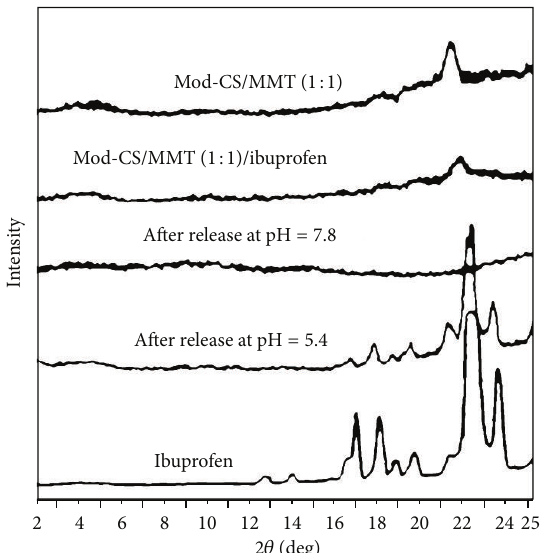
Figure 6: X-ray diffraction pattern of mod-CS, mod-CS/MMT (1:1), ibuprofen, and mod-CS/MMT—ibuprofen on cold after release.